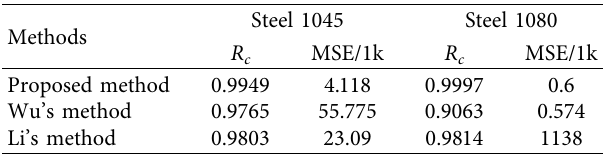
Figure 11: Comparison between experimental data and fatigue life estimated by Li’s method. Table 5: R c and